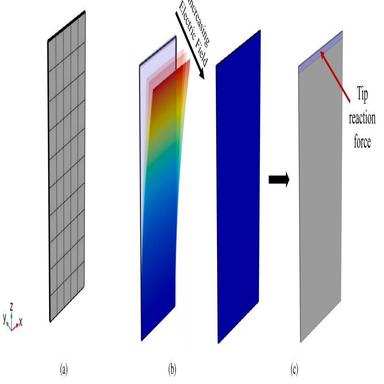
(a) Mapped mesh of the simulated cantilever beam. (b) Tip deflection simulation, in which the deflection increases for increasing applied electric field. (c) Blocking force simulation, in which the actuator is constrained and the reaction force is evaluated.